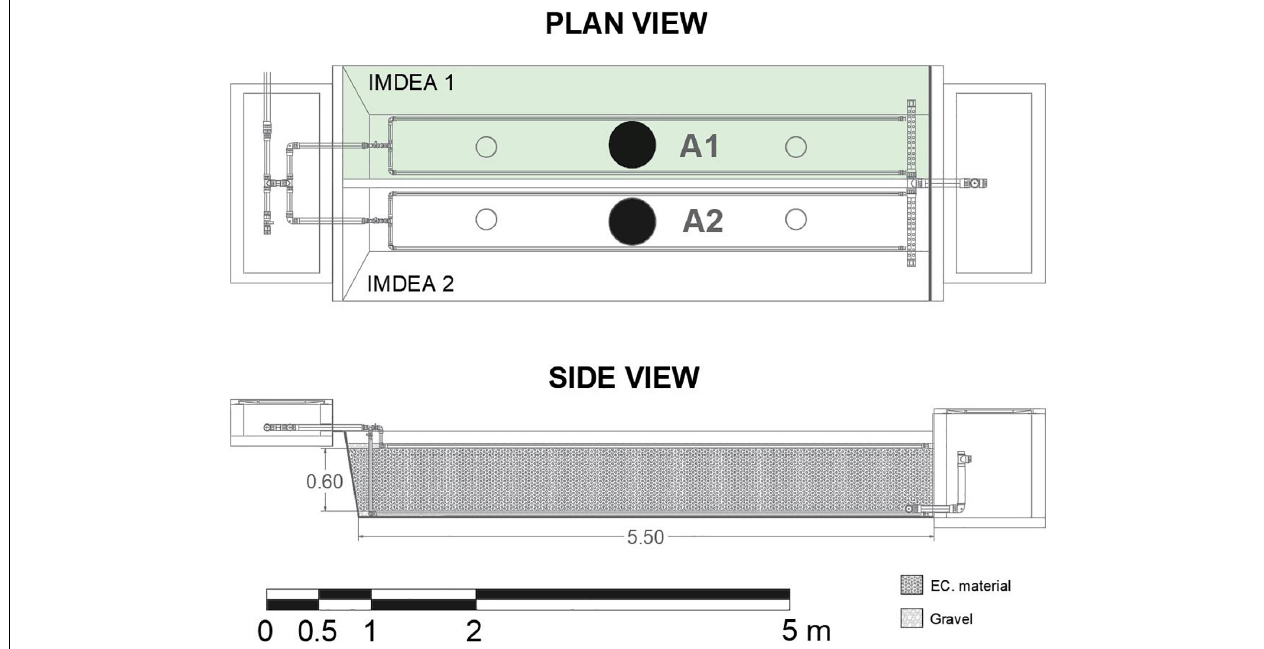
FIGURE 2 | Plan view and profile of the METland system at IMDEA water (Alcalá de Henares). Sample points: A1 = planted with Bambusa bambos , Typha angustifolia , and Iris germanica ; A2 = not